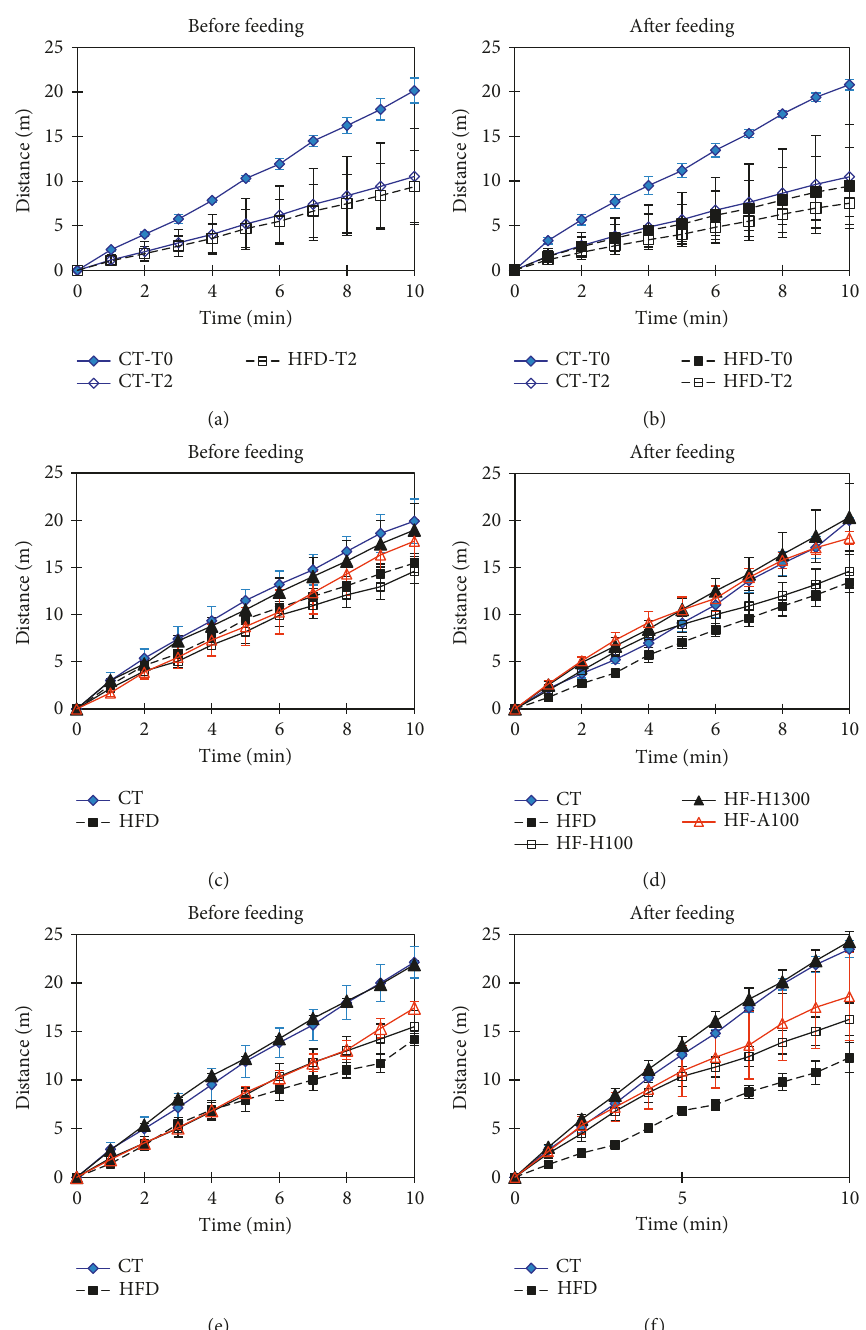
Figure 8: The travel distance of tested mice before (a) and after (b) feeding, (A and B T0 and T2 are week 0 and 2, respectively; C and D are week 4; E and F are week 6) (data were shown in mean ± standard deviation, n �